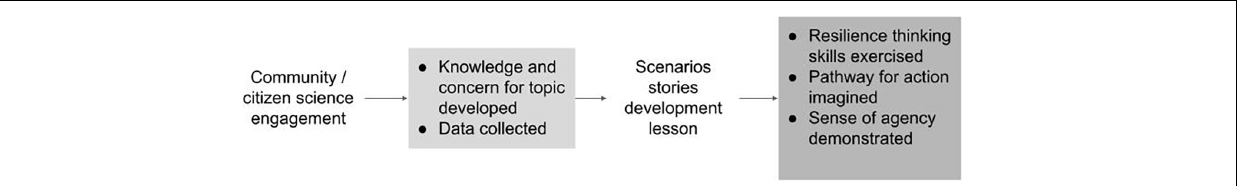
FIGURE 1 | Proposed theory of change model for youth concluding a climate change-related community and citizen science project with a scenarios development mini-workshop.